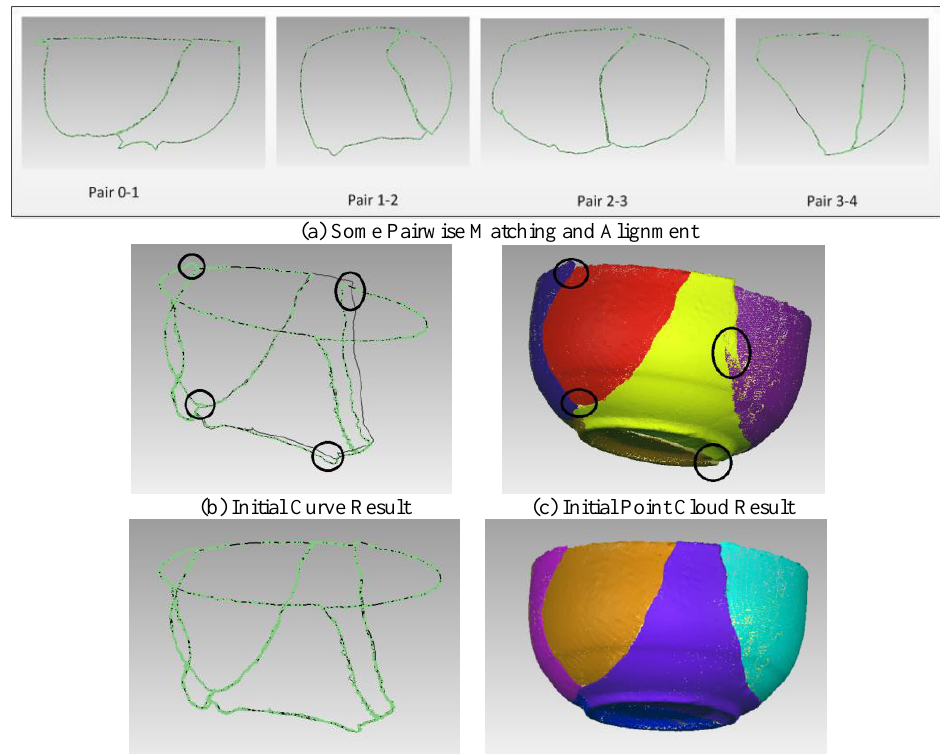
Figure 4. An Matching and Alignment